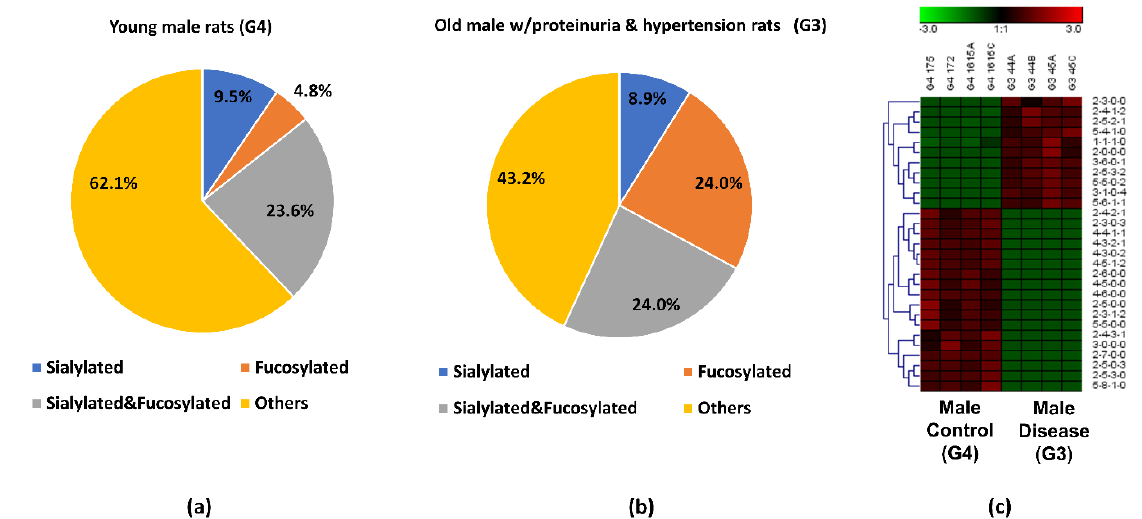
Figure 3. The distribution changes of different O -glycan types from ( a ) young male control (G4), and ( b ) older male with proteinuria and hypertension (G3); ( c ) heatmap of 29 O -glycans that exhibited significant expression changes between G4 and G3. In the heatmap, each row represents an individual significant O -glycan. A red cell denotes a high relative abundance, while green represents a low relative abundance of the O -glycan.